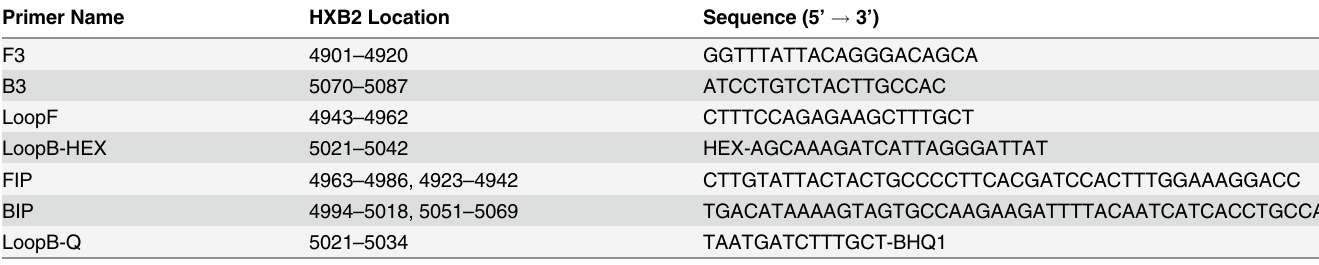
Table 1. INT Primer and Quencher Probe